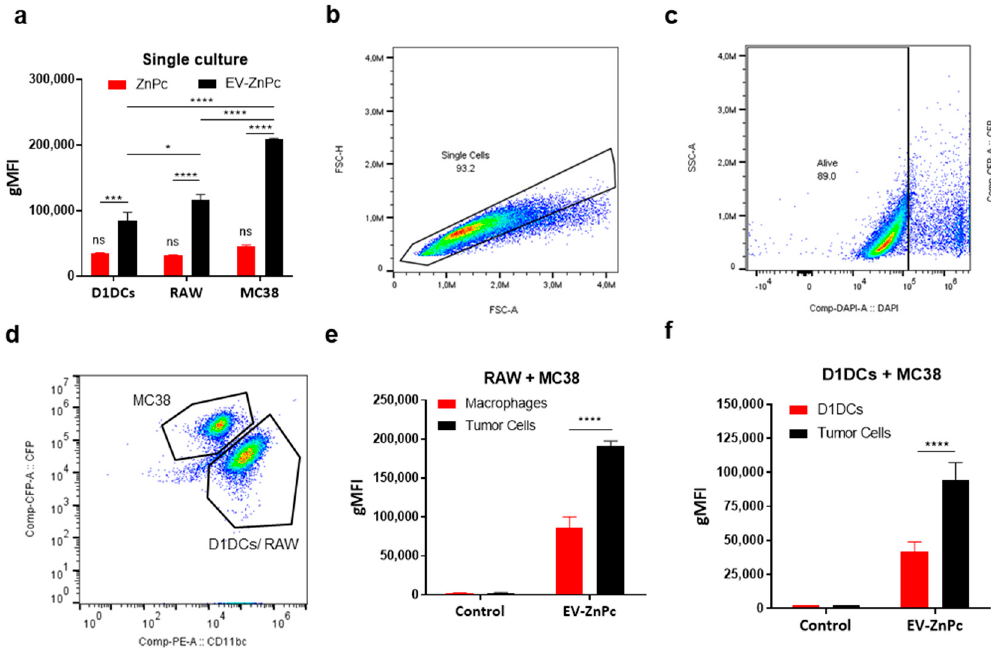
Figure 2. Cell type dependent uptake of EV-ZnPc. ( a ) MC38, D1DCs, or RAW cells were treated with ZnPC alone or EV-ZnPc for 24 h prior to fluorescent detection by flow cytometry using Annexin-V/DAPI staining. MC38-CFP cells were co-cultured with either D1DCs or RAW cells and incubated with EV-ZnPc as described in methods. The fluorescence in the subpopulations was detected by flow cytometry. Gating was performed to exclude debris (not shown), ( b ) single cells and ( c ) dead cells. ( d ) CFP and CD11b/c were used to distinguish the uptake between ( e ) tumor cells and D1DCs or ( f ) tumor cells and macrophages. Data are means ± SEM ( n = 3). **** p < 0.0001; *** p < 0.001; * p <